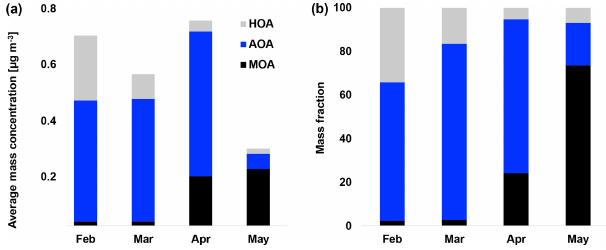
Figure 4. (a) Average mass concentration (µgm − 3 ) of hydrocarbon-like organic aerosol (HOA), Arctic haze organic aerosol (AOA) and marine organic aerosol (MOA) in February, March, April and May. (b) Mass fraction of HOA, AOA and MOA in February, March, April and May.